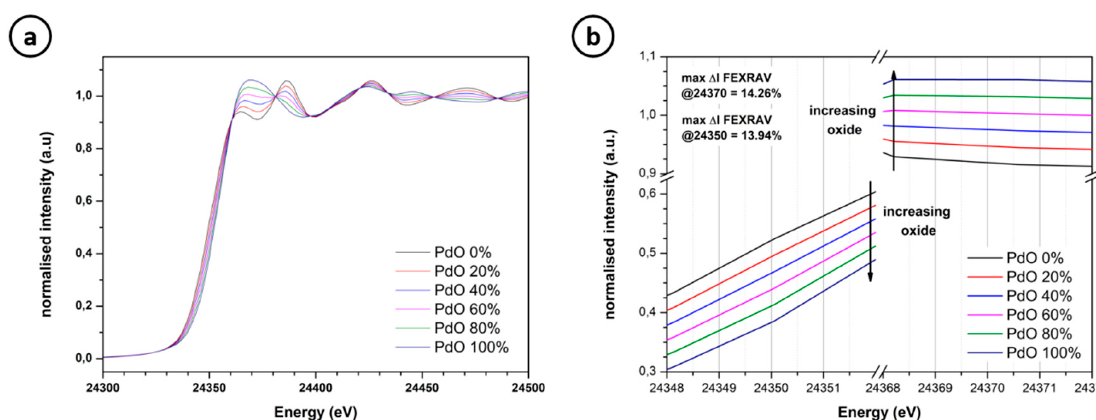
Figure 4. ( a ) Linear combination of X-ray Absorption Near Edge Spectroscopy (XANES) spectra of Pd and PdO with variable molar fraction of PdO; ( b ) The extent of FEXRAV signal variation at 24,370 and 24,390 eV.